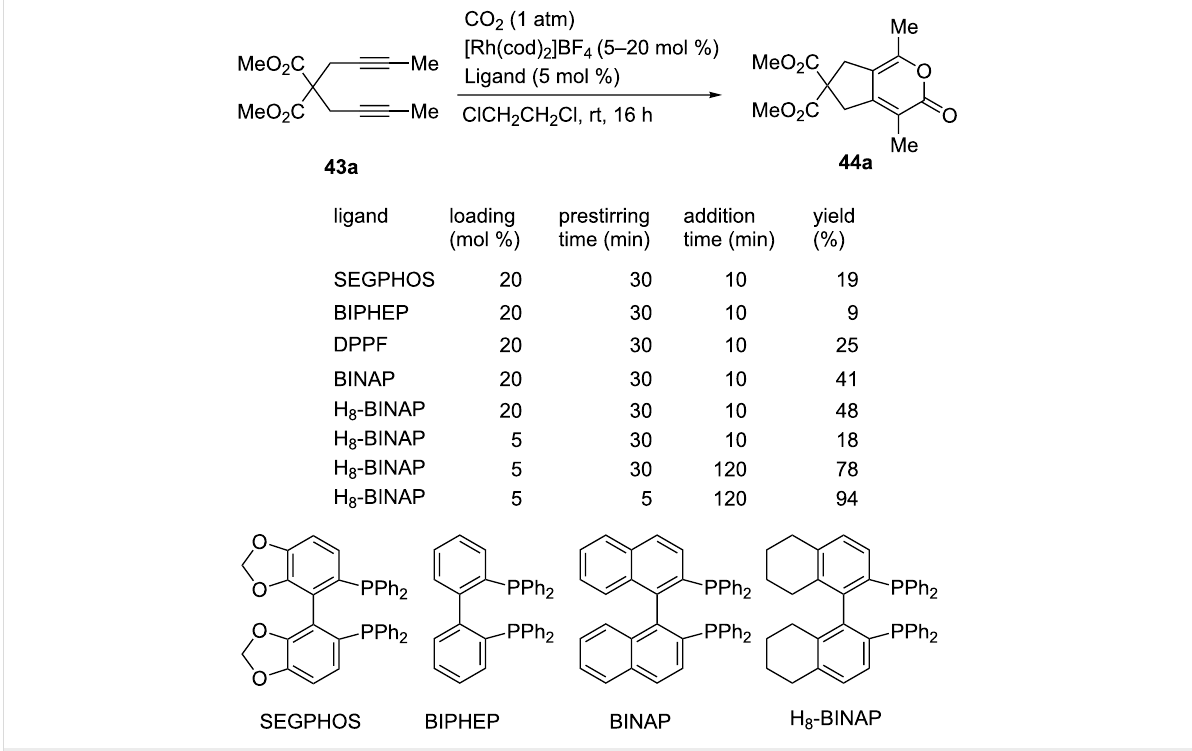
For this transformation, the reaction pathways depicted in Scheme 41 can be envisaged. The Rh(I) species A reacts with a diyne to afford rhodacycle B (step a). Then, the reaction of B with CO 2 produces the seven-membered rhodium intermediate